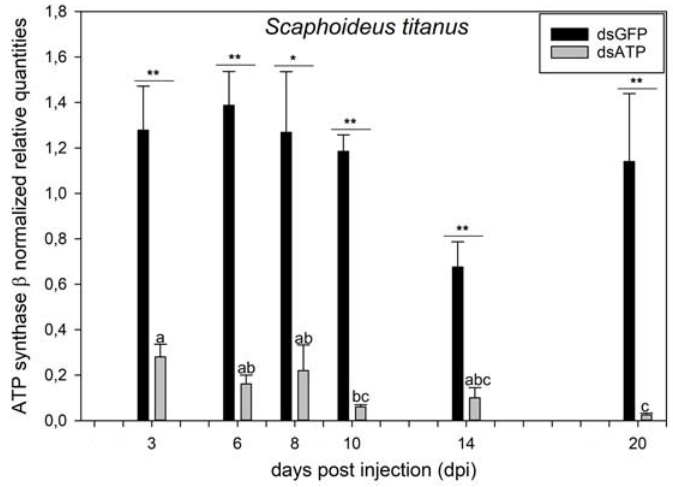
Figure 1. Transcript level of ATP synthase β in Scaphoideus titanus injected with dsRNAs. Mean transcript level of ATP synthase β in insects injected with dsRNAs targeting green fluorescent protein (dsGFP) or ATP synthase β (dsATP) at 3, 6, 8, 10, 14, and 20 days post injection (dpi). Within the same date, asterisks indicate significant differences ( t test) in mean transcript levels of four to five samples ± standard error of the mean (SEM, error bars); * and ** indicate p < 0.01 and p < 0.001, respectively. Within the same treatment (dsGFP or dsATP), different letters indicate significant differences (ANOVA, followed by the Holm–Sidak method).